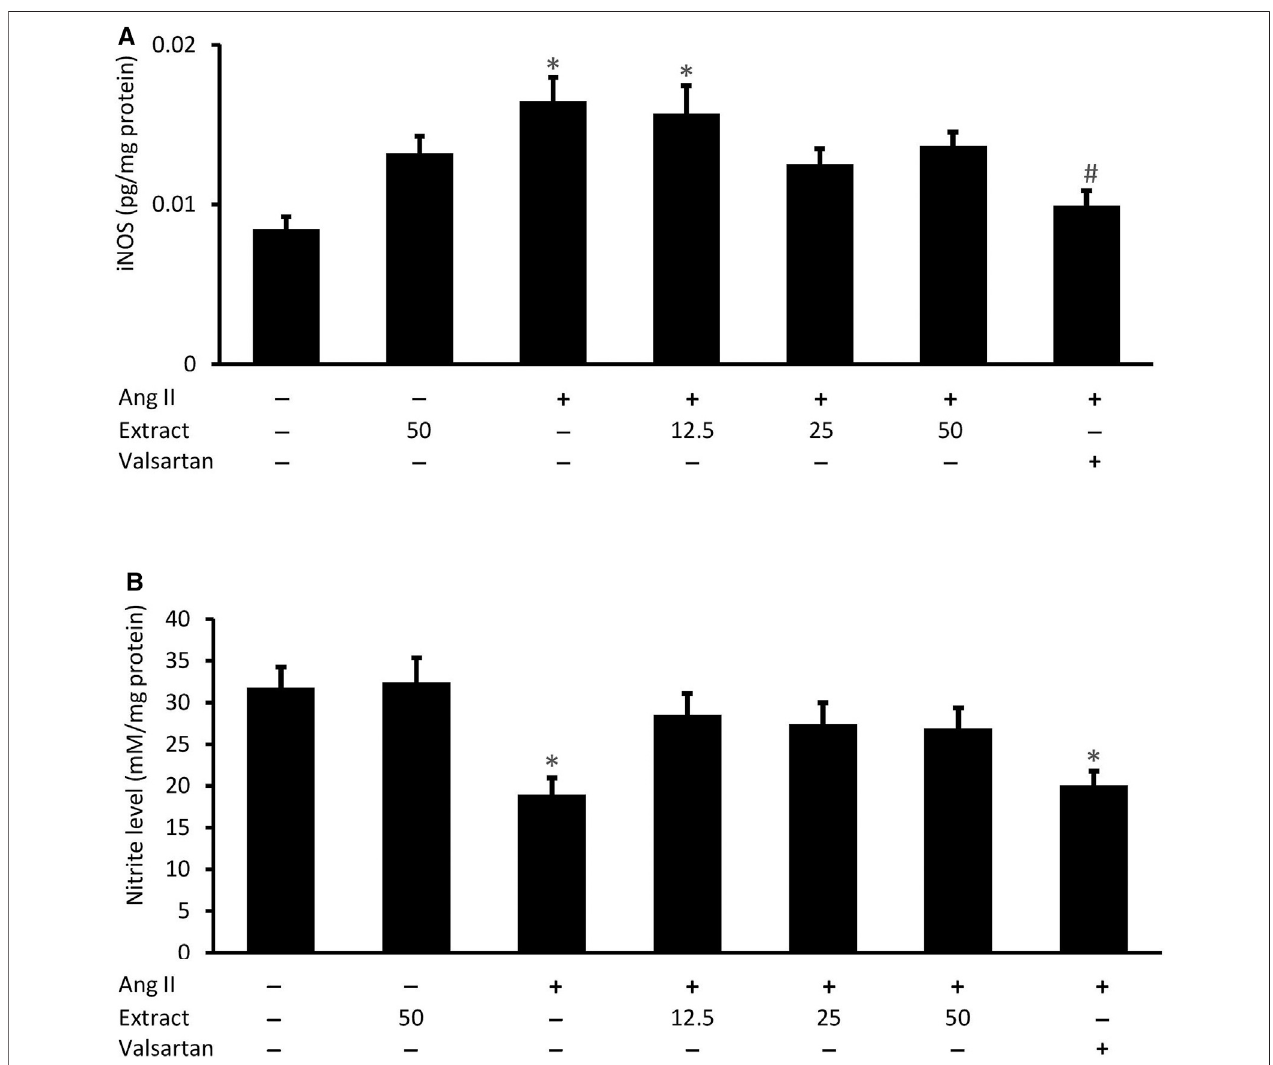
FIGURE9| Cellular (A) induciblenitricoxidesynthase(iNOS)activityand (B) nitritelevelingroupsco-treatedwithAngII(600 nM)andthreeconcentrationsof Parkia speciosa empty pod extract or valsartan (20 μ M, positive control) for 24 h * p < 0.05 vs. control (no treatment) group. # p < 0.05 vs. Ang II cells. Bars represent means ± SEM ( n (cid:2)